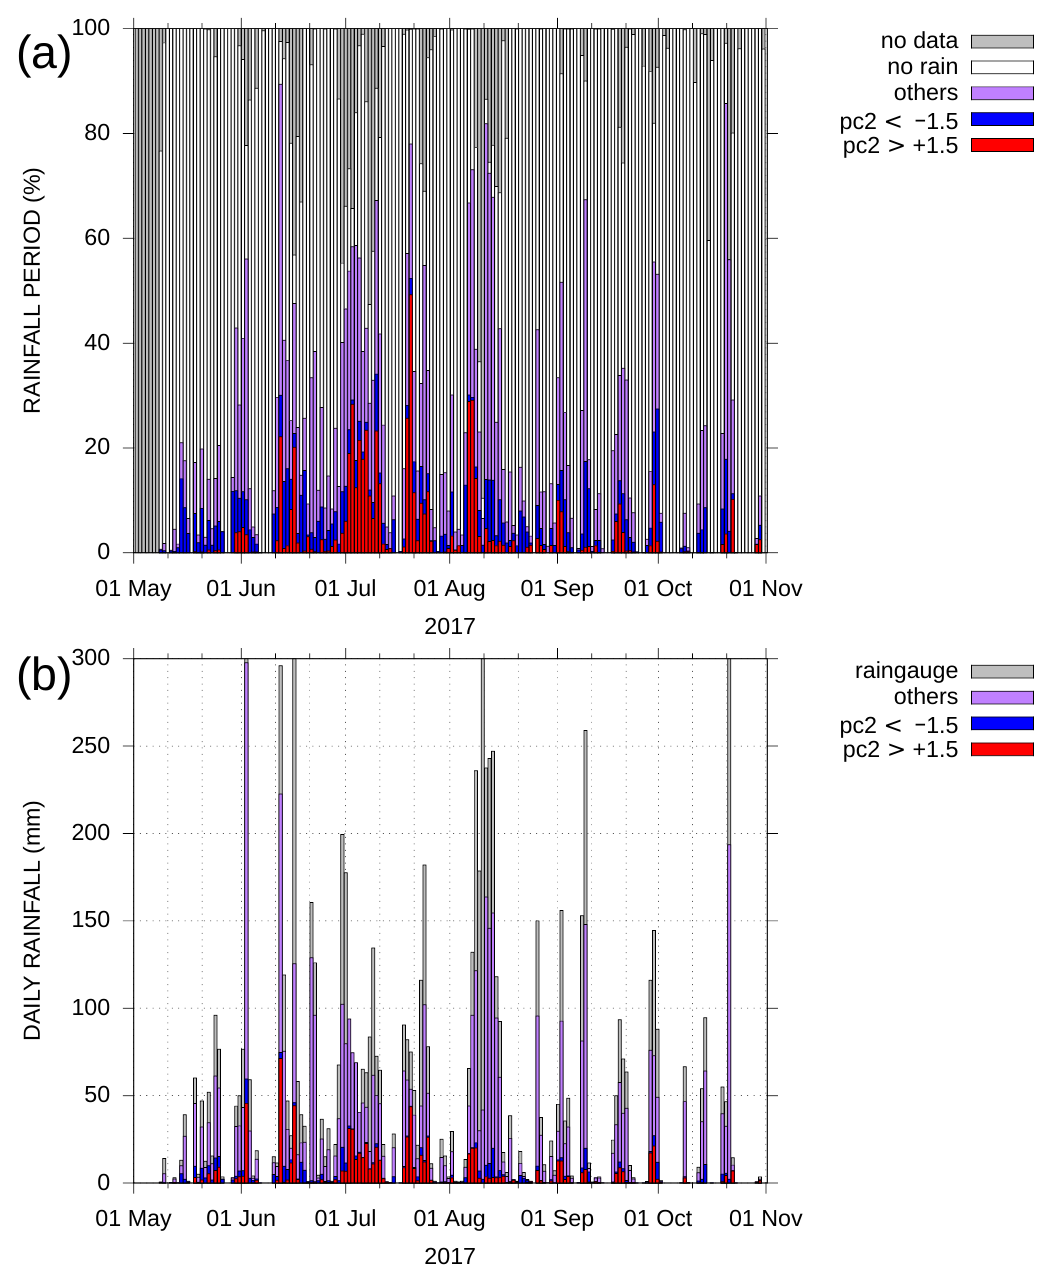
Figure 9. ( a ) The frequency of occurrence in daily rainfall, and ( b ) the accumulated rainfall fractions with PC 2 > + 1.5 (red color) and PC 2 < − 1.5 (blue color), and others (purple color) during 1 May–31 October 2017. The gray bars in ( a ) indicate the periods of missing data due to bad sensor status, and the gray bars in ( b ) indicate the accumulated rainfall observed by the collocated